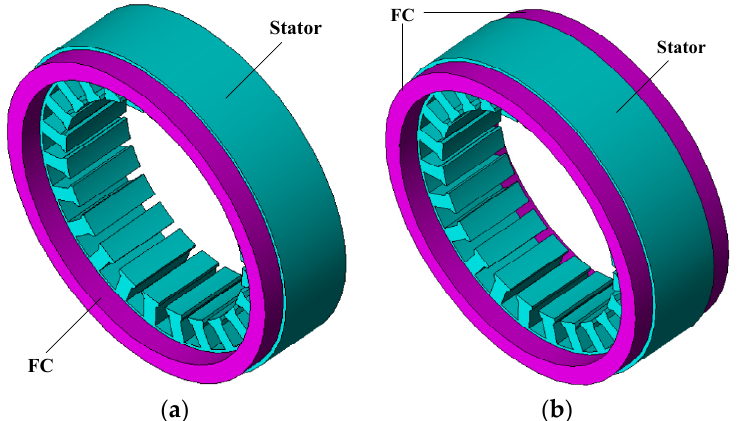
Figure 4. Illustration of toroid FCs located on the stator extremities in mixed ‐ exited HE. ( a ) FC on the stator, one extremity. ( b ) FCs on the stator, both extremities.